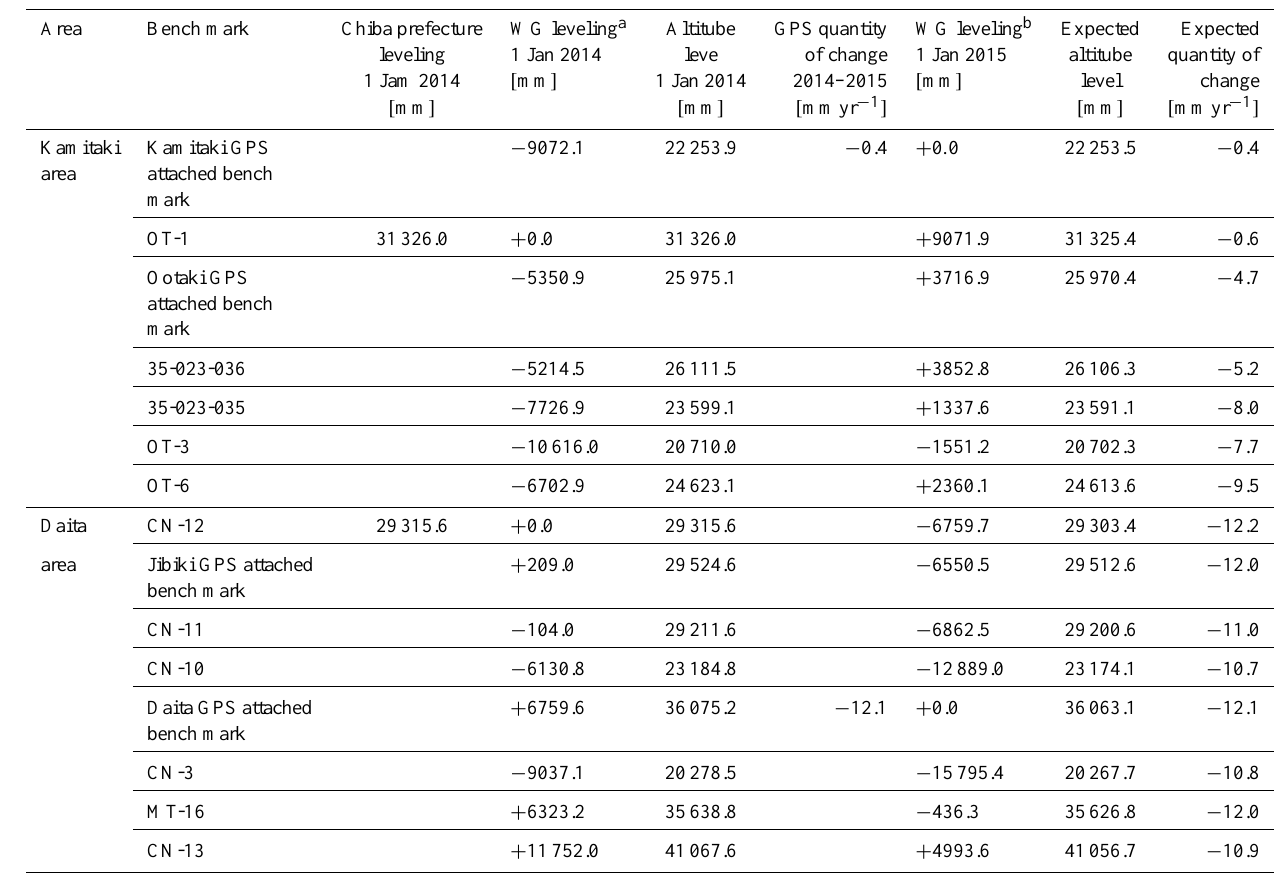
Table 4. The change predicted value that put leveling and GPS together.